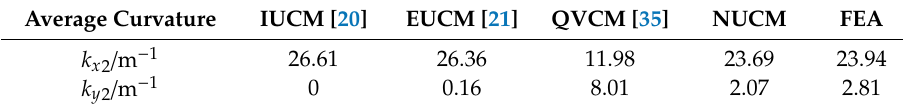
Table 2. Comparison of the average curvatures with analytical models and simulation. Average Curvature IUCM [20] EUCM [21] QVCM [35] NUCM